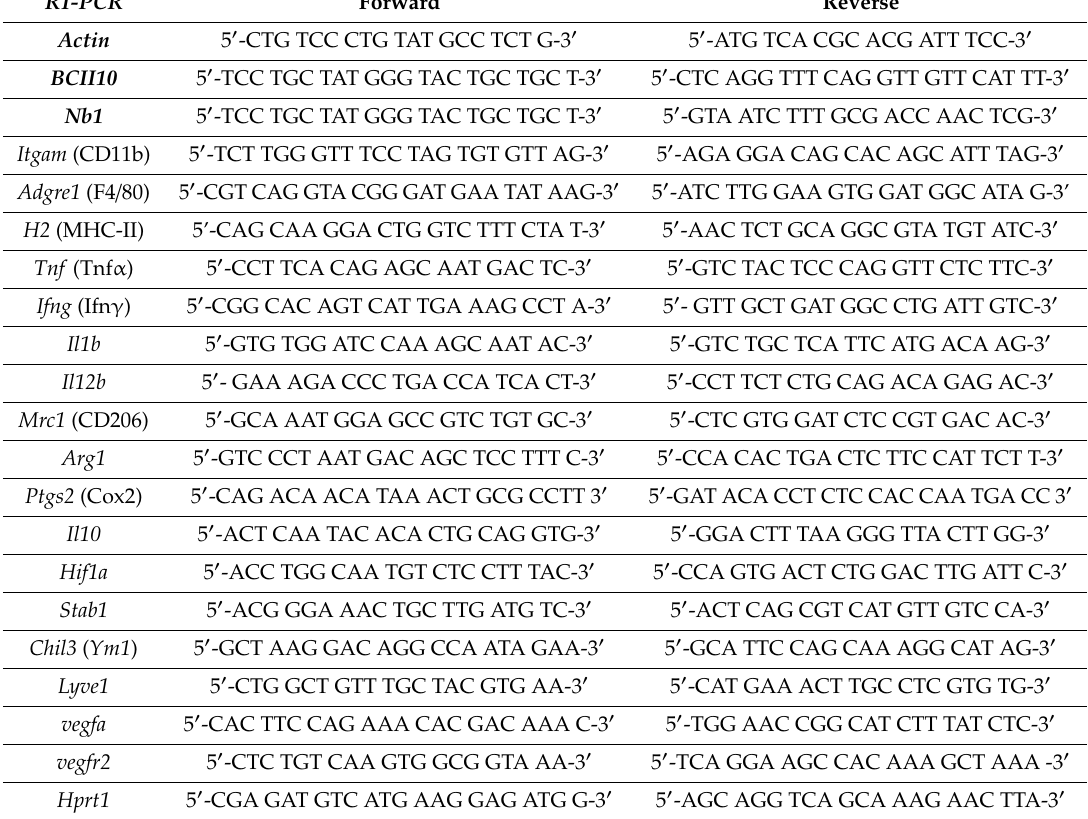
Table 1. Primers used in RT-PCR or